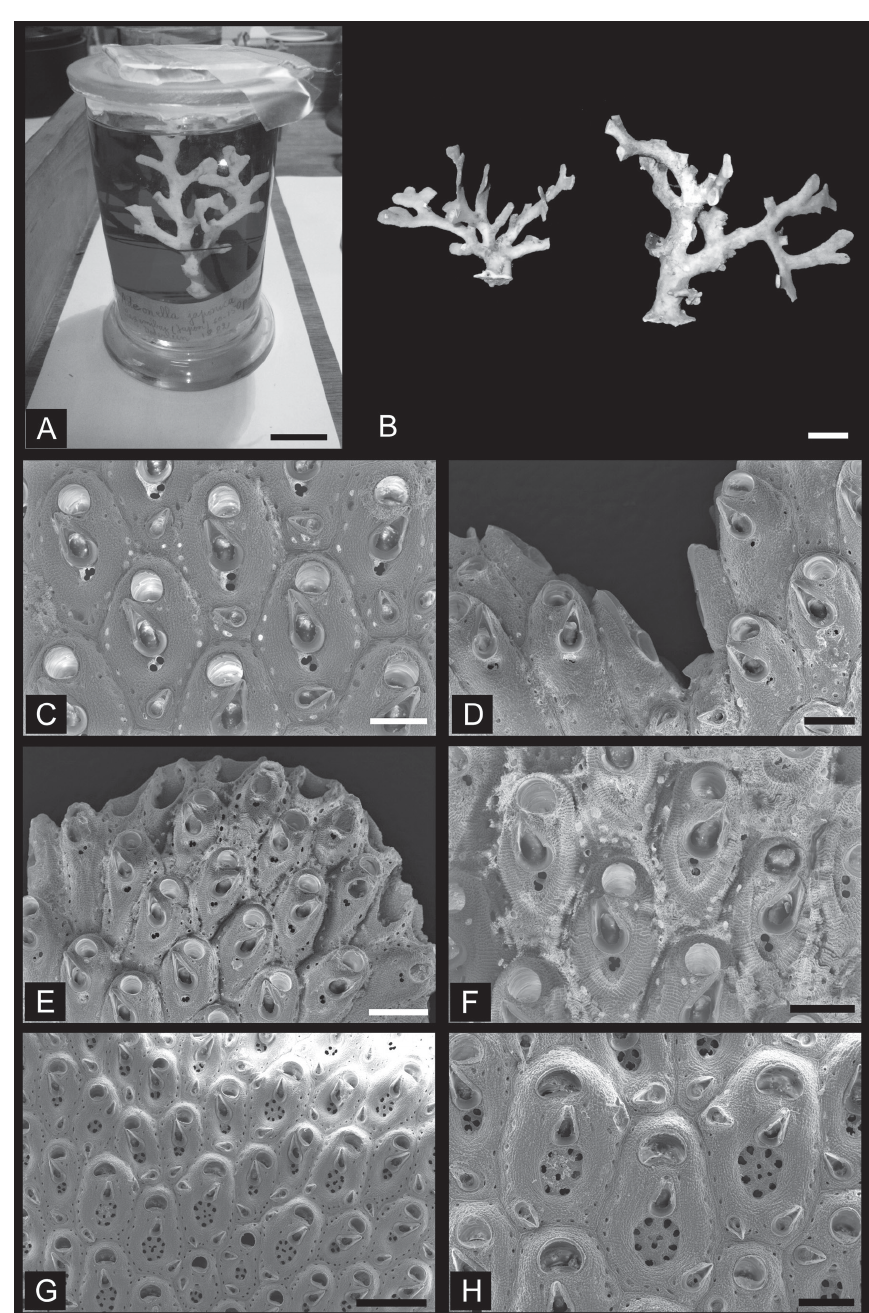
Fig. 7. Adeonellopsis japonica (ortmann, 1890) . A . Lectotype from among ortmann’s specimens in the Döderlein Collection (MZs 3-3). B . Colonies collected at otsuchi (NsMT-Te760). C . Autozooids with large suboral avicularium and biporous spiramen (NsMT-Te741, from lectotype, MZs 3-3). D . Lateral vicarious avicularia at branch bifurcation (NsMT-Te741, from lectotype, MZs 3-3). E . Young autozooids at distal end of branch (NsMT-Te741, from lectotype, MZs 3-3). F . Young autozooids, with biporous spiramen surrounded by thick, swollen rim bearing rows of granulation (NsMT-Te741, from lectotype, MZs 3-3). G . Autozooids and gonozooids at branch bifurcation (NsMT-Te742, from paralectotype MZs 3-4). H . Gonozooids showing large multiporous spiramen (NsMT-Te742, from paralectotype MZs 3-4). A–B = optical photographs; C–H = seM images. scale bars: A = 2 cm; B = 1 cm; C–D, F, H = 200 μm; E = 300 μm; G = 500